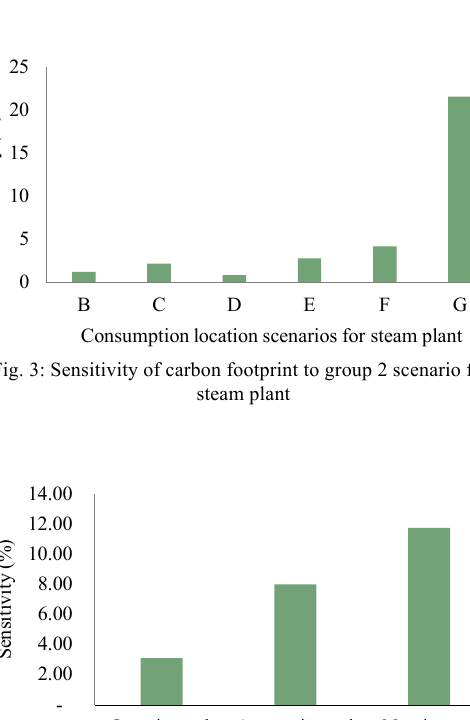
Fig. 2: Sensitivity of carbon footprint to group 1 scenario for steam plant